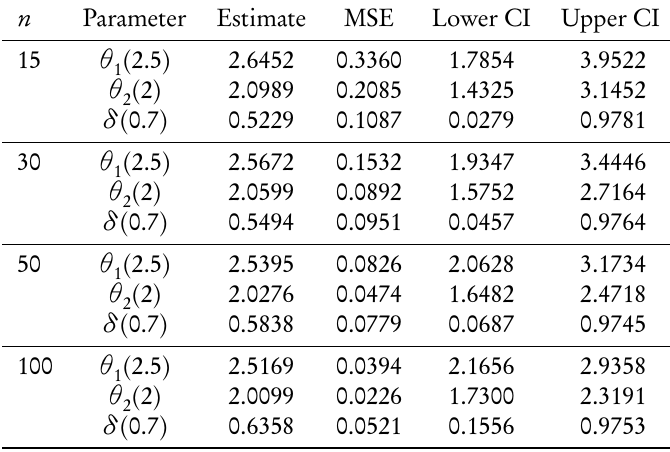
Simulation study of the parameters of BXG distribution (Case 3 -